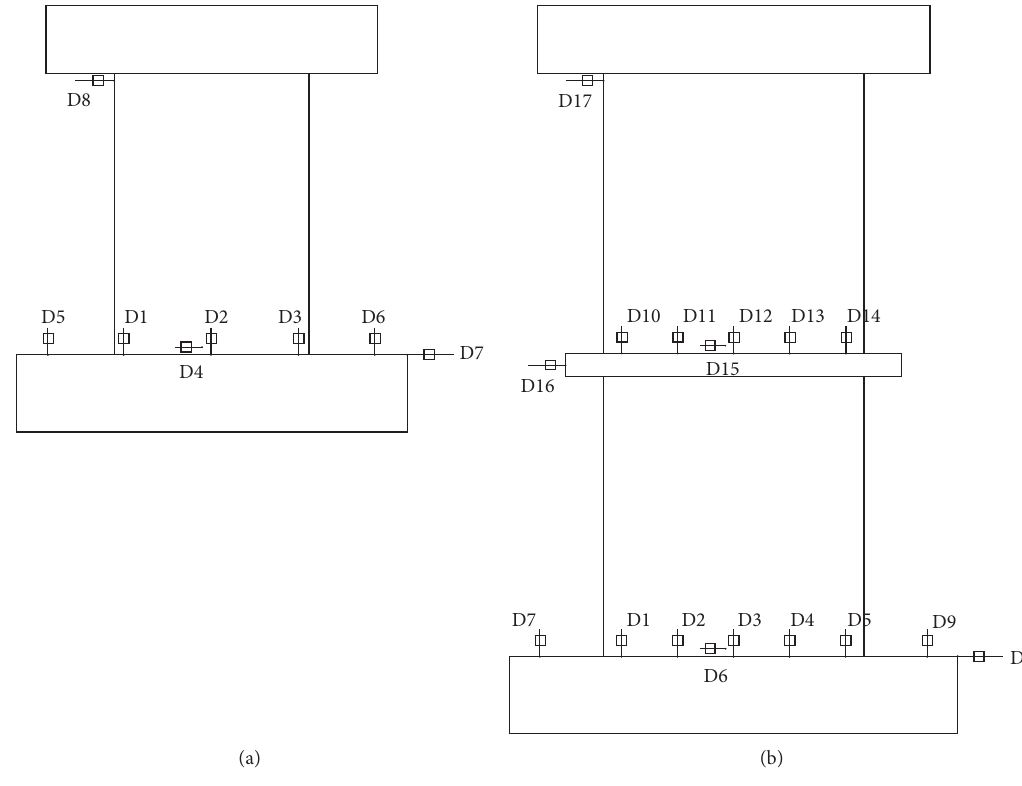
Figure 5: Measurement scheme. (a) Group 1. (b) Group